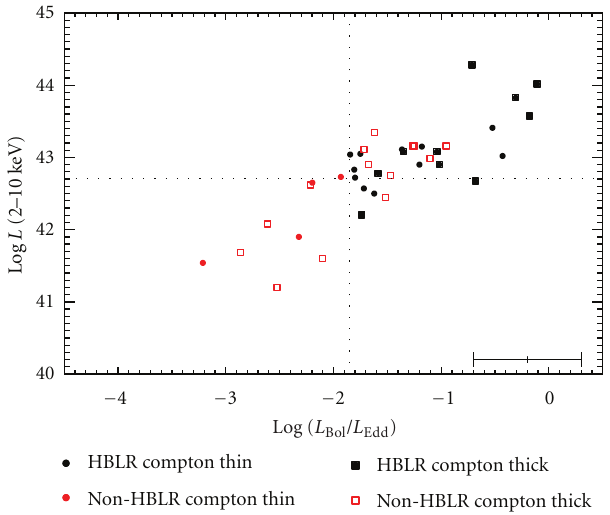
Figure 6: The separation between Seyfert 2 with detection of polarized broad lines (hidden BLR, HBLR) and Seyfert 2s without polarized broad lines (non-HBLR) is clear both in X-ray luminosity and Eddington rate, when only Compton-thin sources are taken into account. However, a number of Compton-thick Non-HBLR sources have high accretion rates and luminosity, suggesting that obscuration also plays an important role in the detection of the HBLR (from Marinucci et al. [113]).